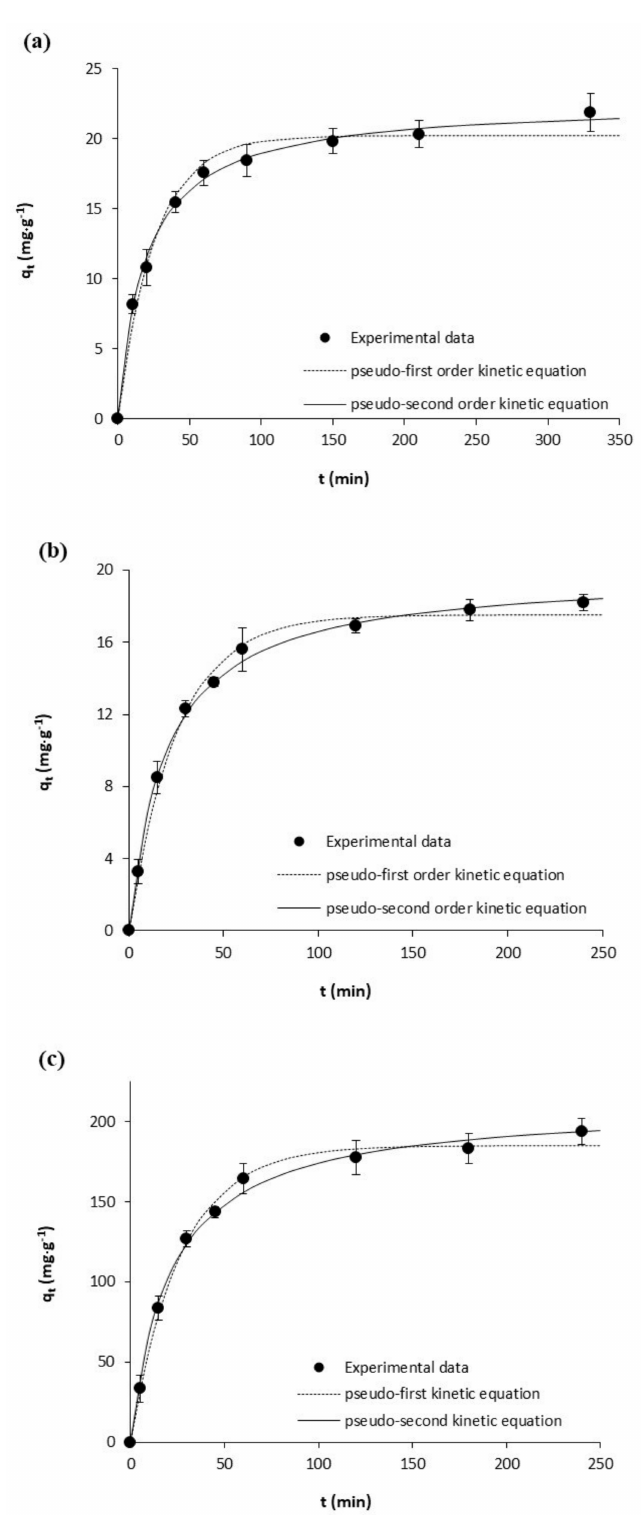
Figure 1. Kinetic results on the adsorption of diclofenac onto ( a ) Scenedesmus sp. biomass; ( b ) Synechocystis sp. biomass; and ( c ) activated carbon. Experimental data on the adsorbed concentration of diclofenac ( q t , mg · g − 1 ) versus time ( t , min) are represented together with fittings to the pseudo-first and pseudo-second order kinetic equations. Notes: Error bars stand for standard deviation (N = 3). The scale of the axis has been adjusted for a better visualization of